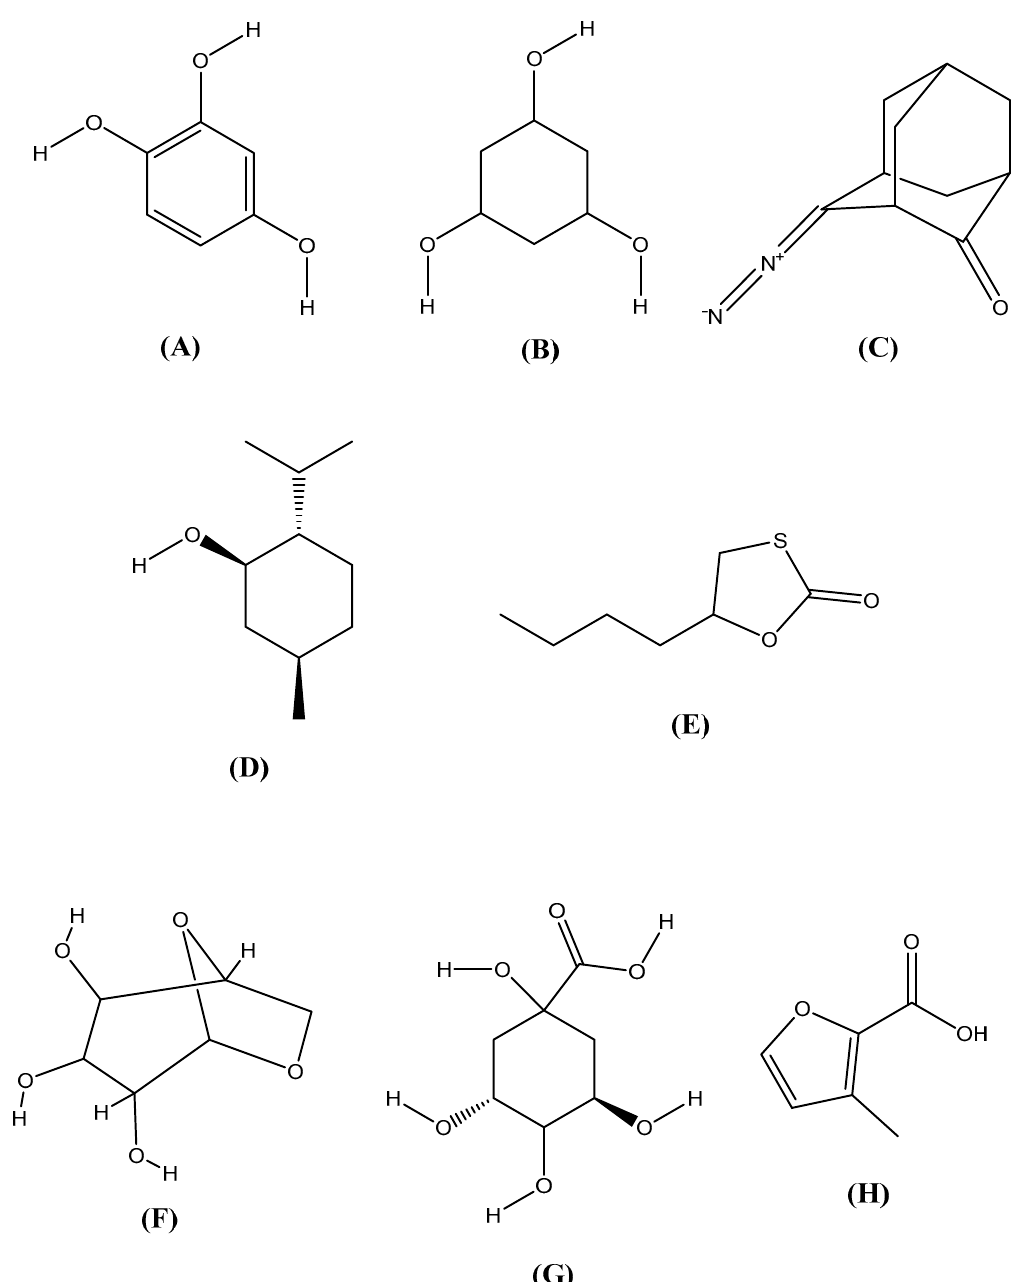
Figure 4. Chemical structure of ( A ) 1,2,4-Benzenetriol, ( B ) Phloroglucinol, ( C ) 4-Diazodamantanone, ( D ) Levomenthol, ( E ) 5-Butyl-1,3-oxathiolan-2-one 5, ( F ) β - D -Glucopyranose, 1,6-anhydro-, ( G ) Quinic Acid, and ( H ) 3-Methyl-2-furoic acid (structures were drawn using ChemDraw Professional 16.0).